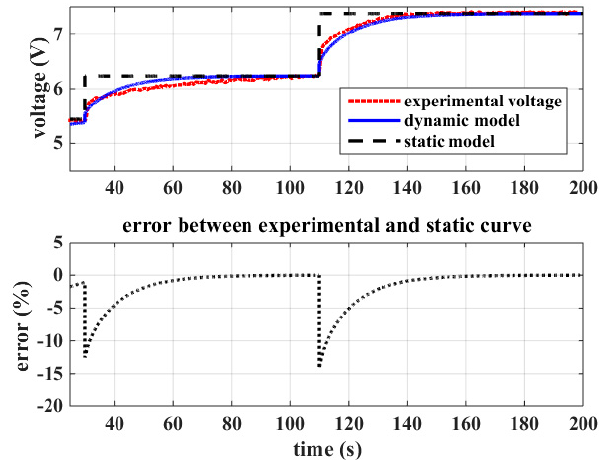
Figure 9. Comparison of different voltage profiles obtained at the terminals of the PEM-EL.